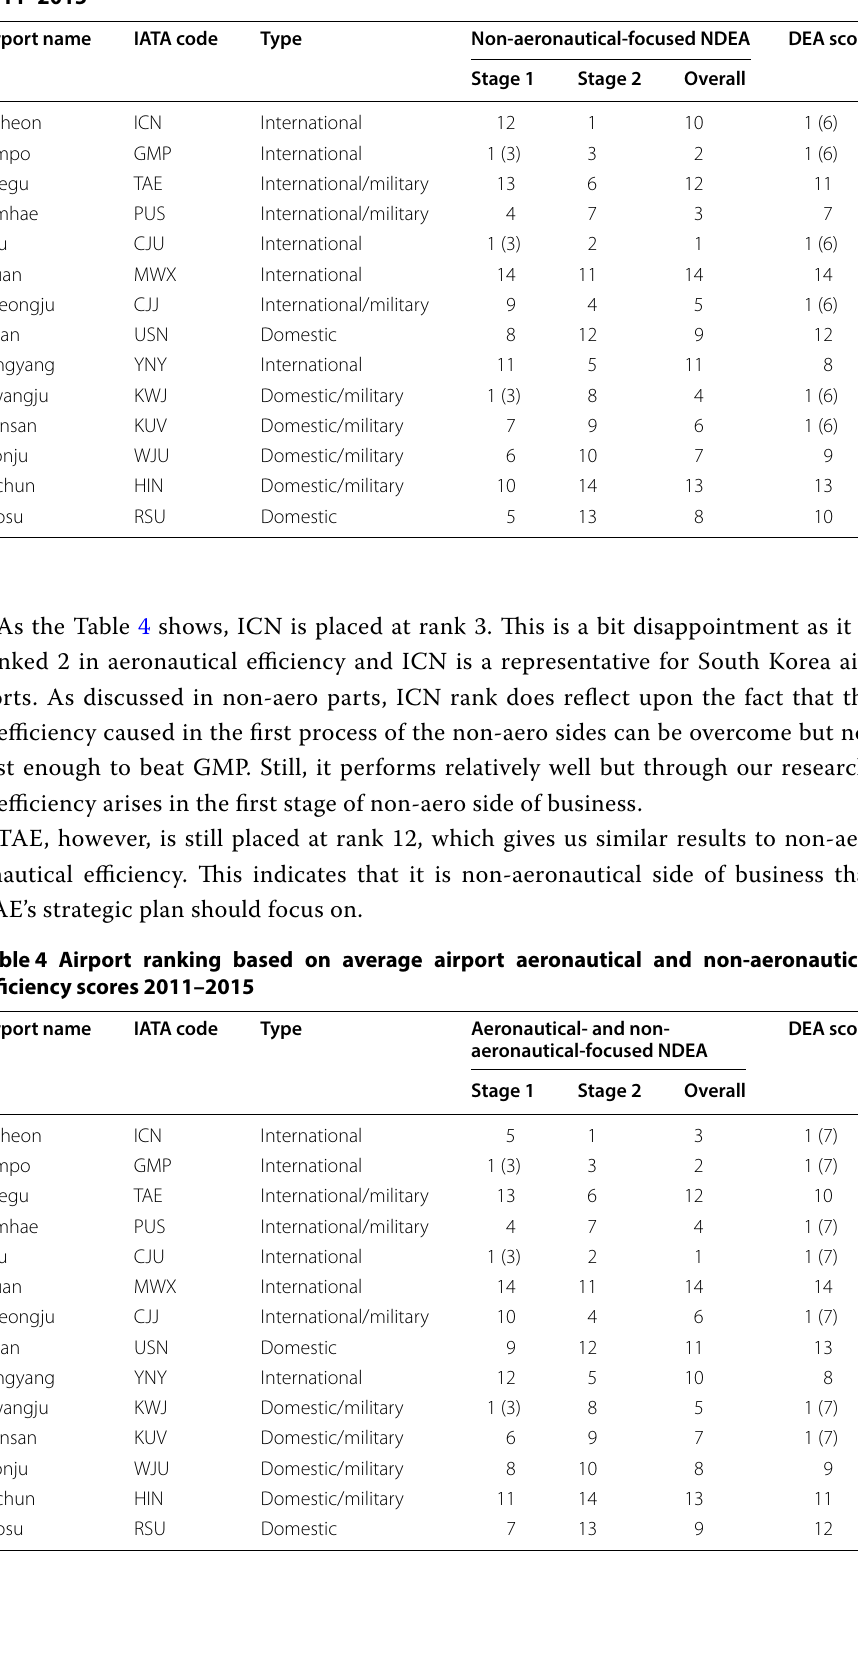
Table 3 Airport ranking based on average airport non-aeronautical efficiency scores 2011–2015